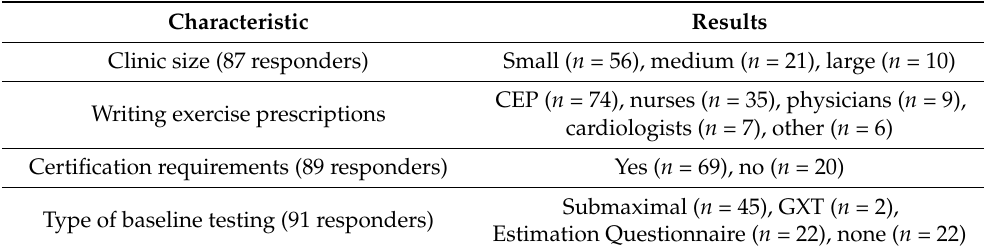
Table 1. Cardiac rehabilitation program